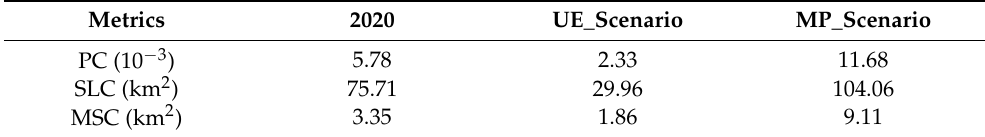
Table 4. Landscape connectivity at the global level in 2020 and under two